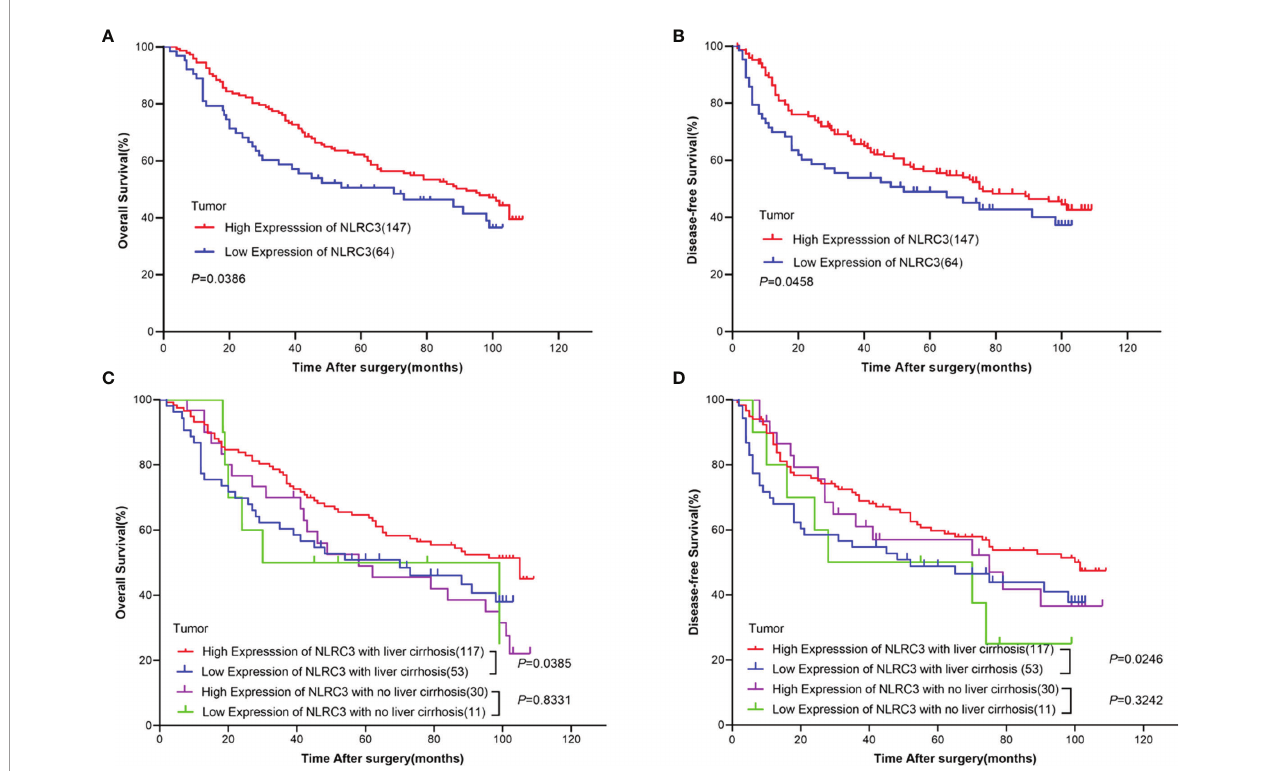
FIGURE 2 | High NLRC3 expression correlated with favorable prognostic in HCC patients. (A) The OS in NLRC3 high expression group was higher than NLRC3 low expression group by Kaplan-Meier analysis, ( P =0.0386). (B) The DFS in NLRC3 high expression group was higher than NLRC3 low expression group by Kaplan- Meier analysis, ( P =0.0458). (C) The OS in NLRC3 high expression group was higher than NLRC3 low expression group by Kaplan-Meier analysis in patients with a history of cirrhosis, ( P =0.0385). (D) The DFS in NLRC3 high expression group was higher than NLRC3 low expression group by Kaplan-Meier analysis in patients with a history of cirrhosis, ( P